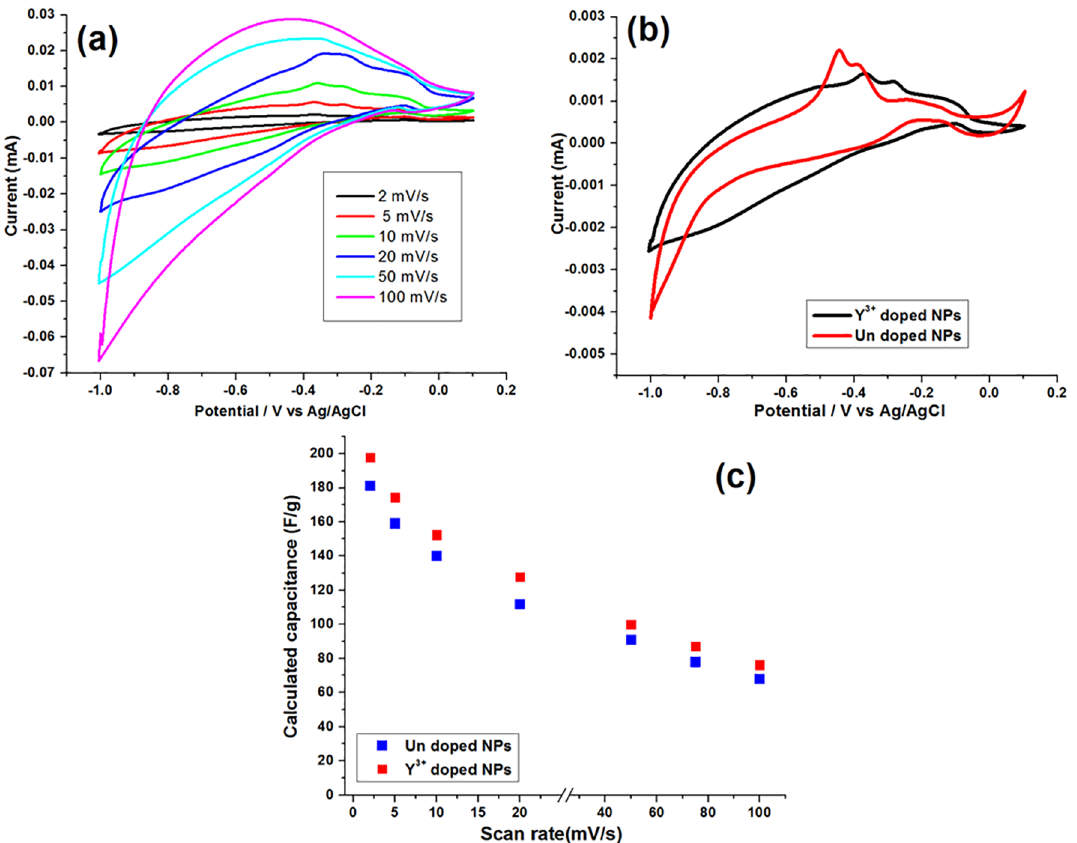
Fig. 5. (a) CVs of the fabricated Y-IONPs working electrode at the various scan rates, (b) (c) CV Yofiles for undped and Y3+doped MNPs at the scan rate of 5mV/s, and (c) the calculated specific capacitances for both electrodes vs. scan rate.